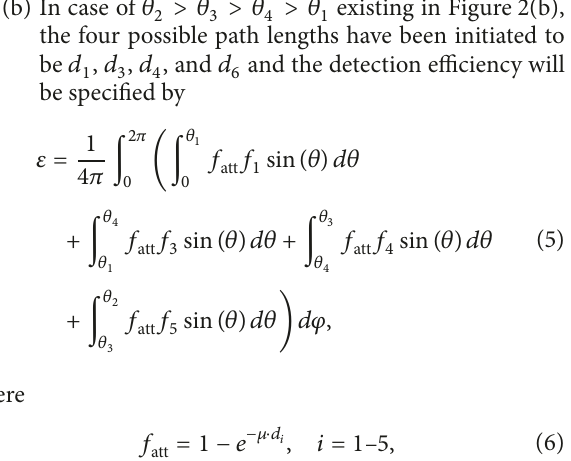
Figure 1: Well-type detector with an isotropic radiating axial point source in the detector